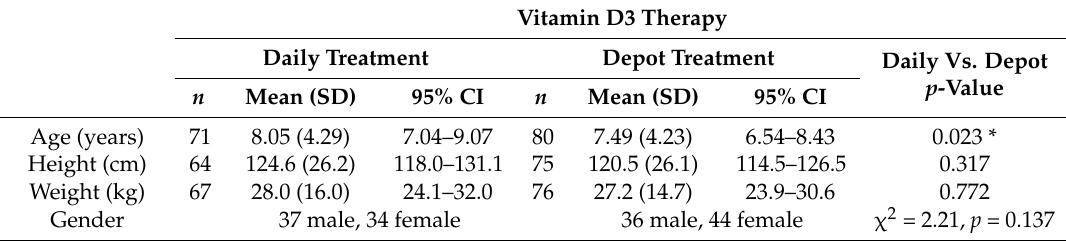
Table 1. Baseline characteristics of study